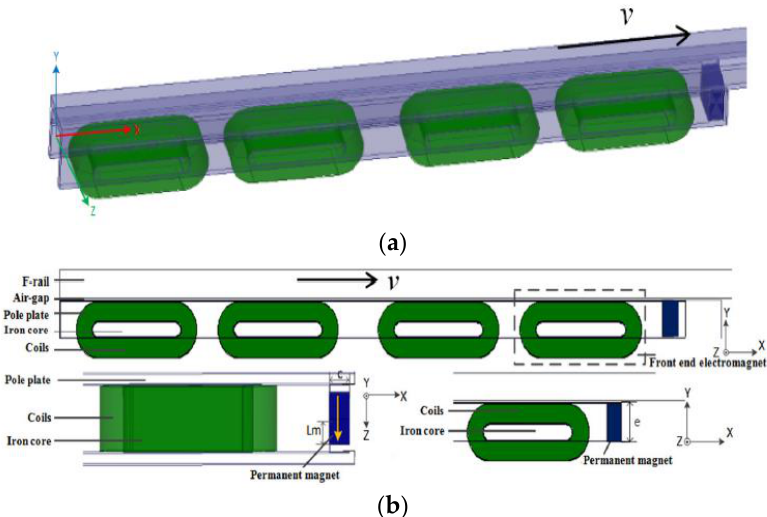
Figure 6. Hybrid excitation structure: ( a ) 3D FEM; ( b ) the lateral view.